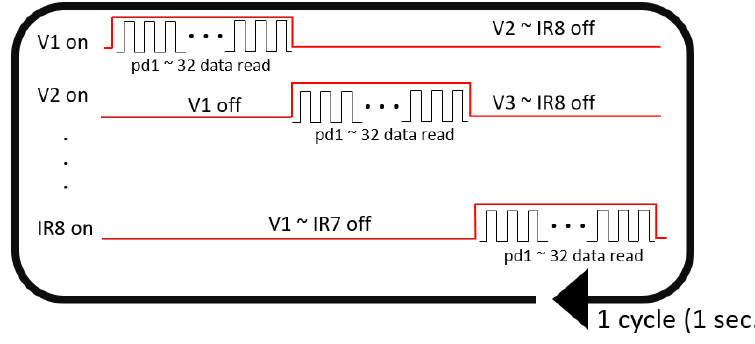
Figure 7. The operating process of the LED sources and Photodiode (PD) detectors for the single cycle of the MSP data acquisition. One of the 16 LEDs at the first visual channel (V1) begins to turn on and each of the 32 PDs detects optical signals in sequence. Then, after an interval, the next LED at the second visual LED channel (V2) turns on and the PDs detect the signals. This process is repeated for each of eight visual LEDs (V1-V8) and eight infrared LEDs (IR1-IR8). The entire process spans approximately 1 s.